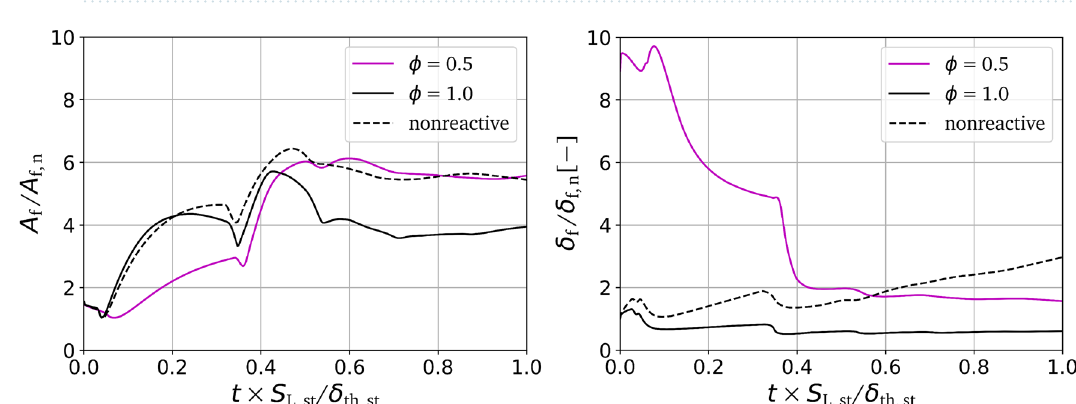
Figure 4. Normalized frequency of FSI topologies over normalized time for φ cases.